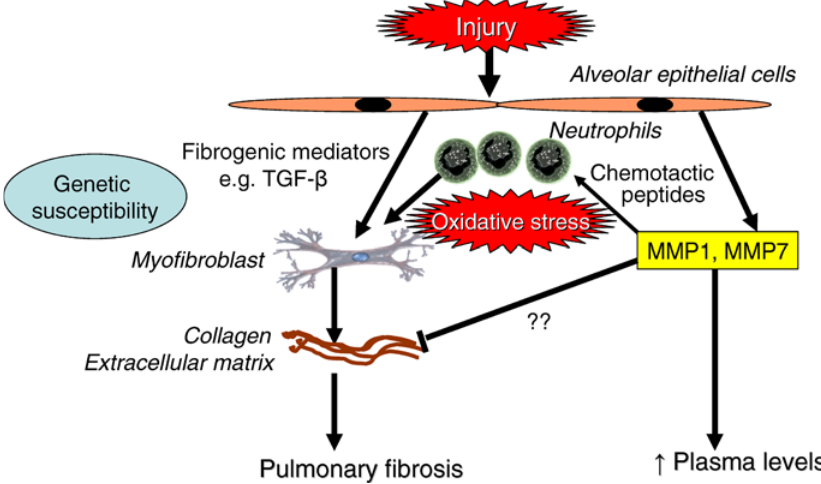
Figure 1. Mechanisms of IPF Injury of alveolar epithelial cells releases fibrogenic mediators, such as TGF-β, which stimulate myofibroblasts to produce extracellular matrix proteins. Matrix metalloproteinases MMP1 and MMP7 are also produced and may reflect tissue remodelling or contribute to fibrosis through recruitment of neutrophils, which release reactive oxygen species and TGF-β. Increased plasma concentrations of MMPs may therefore reflect increased extracellular matrix turnover and disease